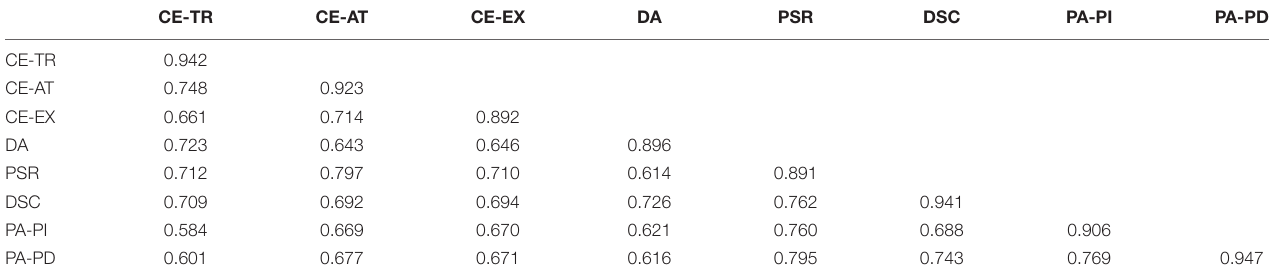
TABLE 3 | Fornell-Larcker criterion.